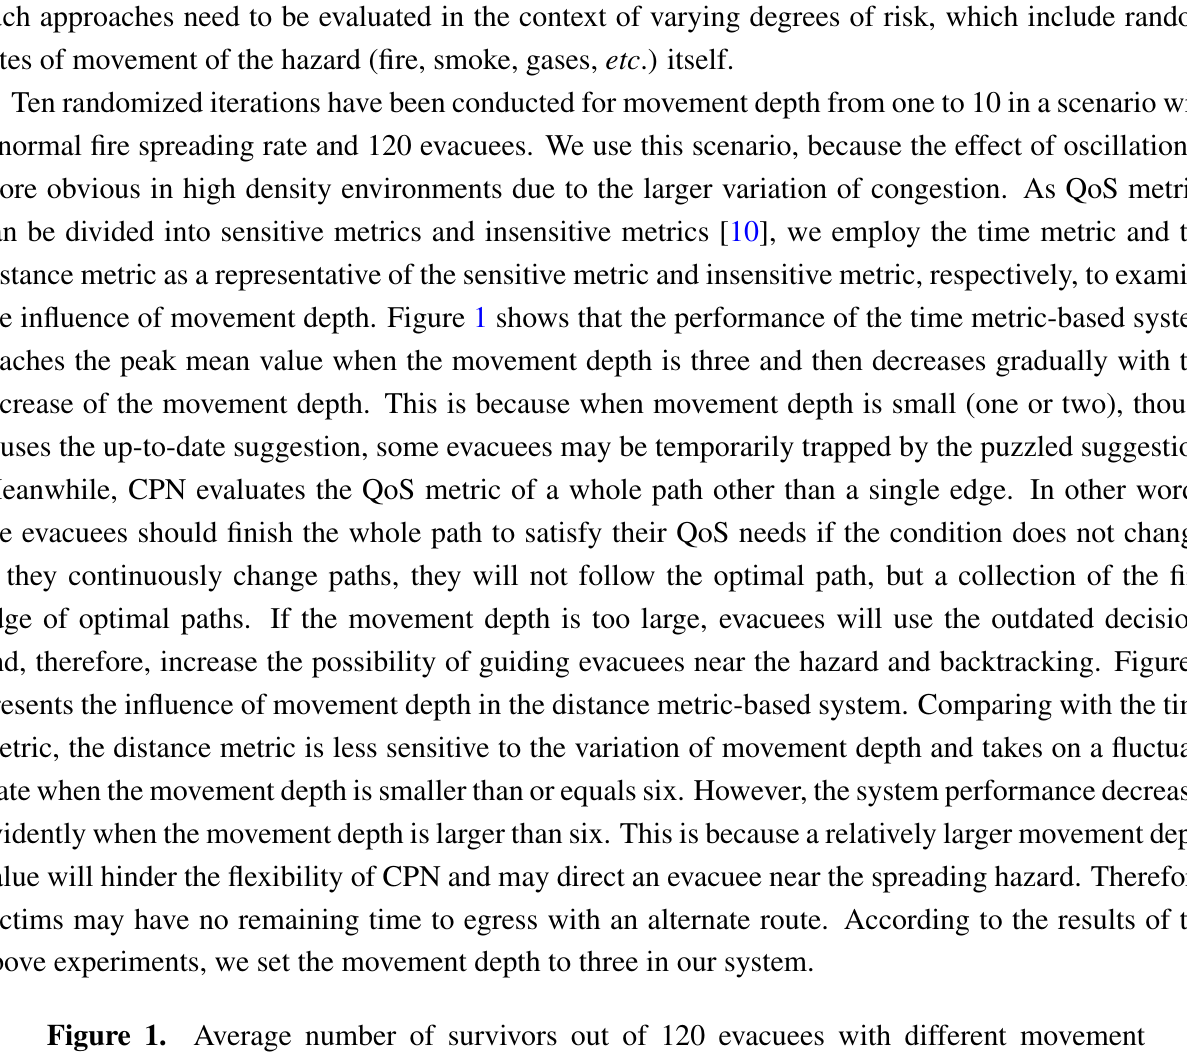
Figure 1. Average number of survivors out of 120 evacuees with different movement depths in the time metric-based system. The error bars show the standard deviation of 10